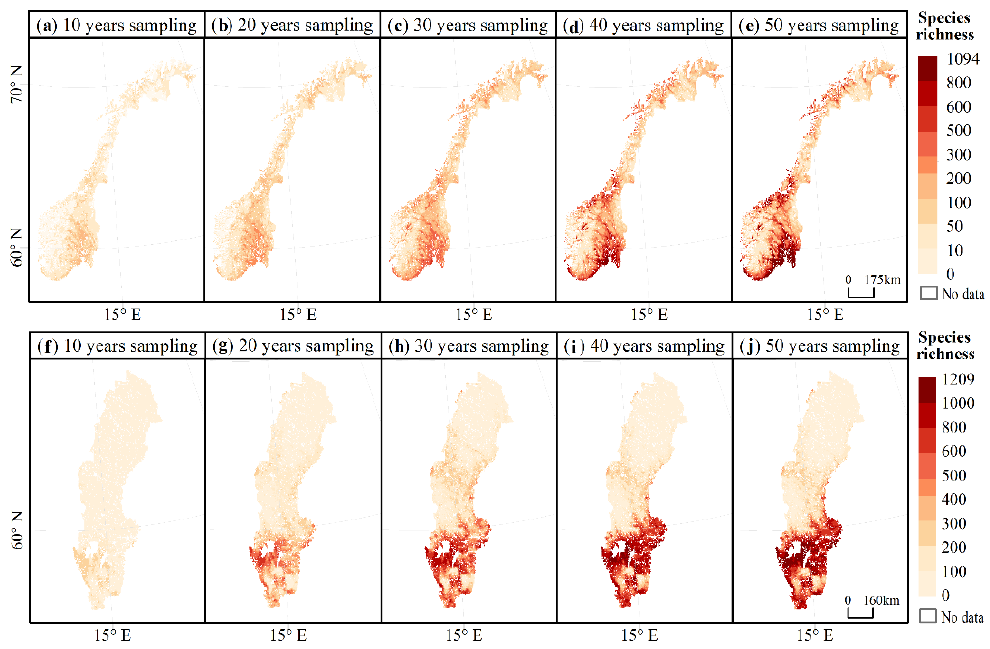
Figure 6. Modelled distribution of macrofungal species richness under different accumulated sam-